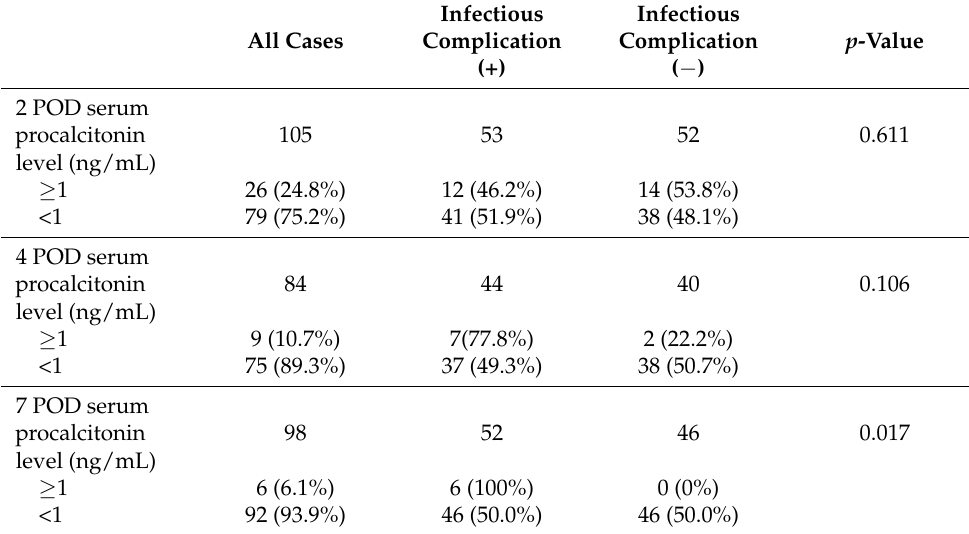
Table 2. The relationship between PCT level and infectious complications.